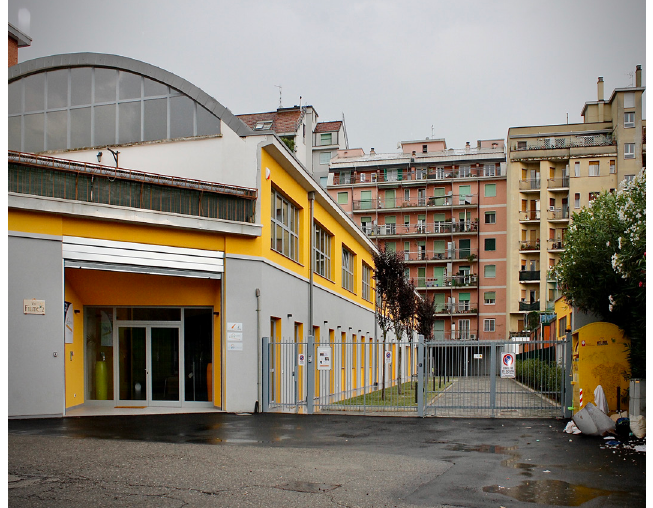
Fig. 2 In the 1950s, speculative housing built industrial warehouses alongside uninterrupted rows of buildings with no common areas. Today both have been renovated and the warehouse is a hub of social